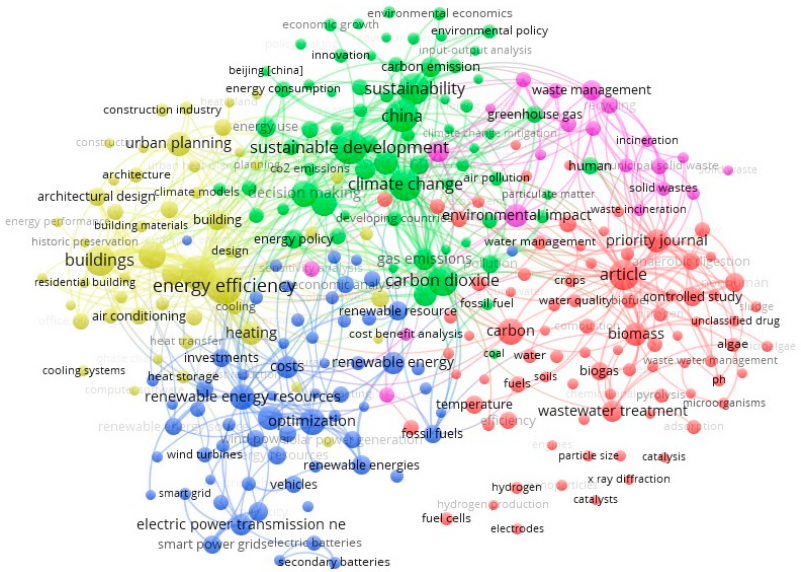
Figure 14. Co-occurrence-keywords.